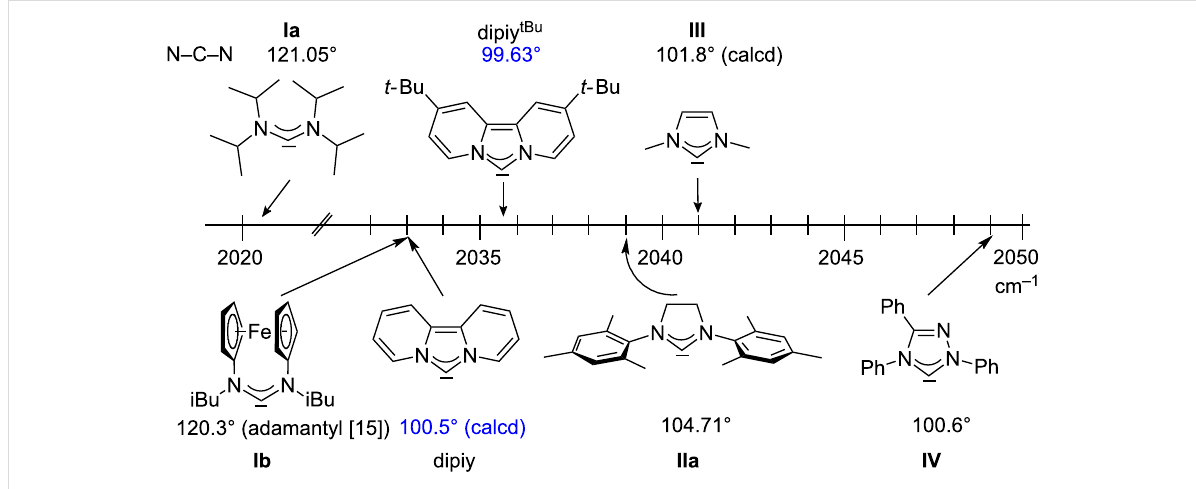
Figure 3: IR scale (cm − 1 ) to determine the overall electron-donor capacity of various N-heterocyclic carbenes based on the average wavenumber of the CO stretching frequencies of their respective Rh(CO) 2 Cl complexes. The strongest donating NHCs are found on the left side (lower ), the weakest on the right side (higher ). In addition the N–C–N angles are given (from X-ray, if not marked otherwise. For Ib the mean value for the N -adamantyl substituted species is given).